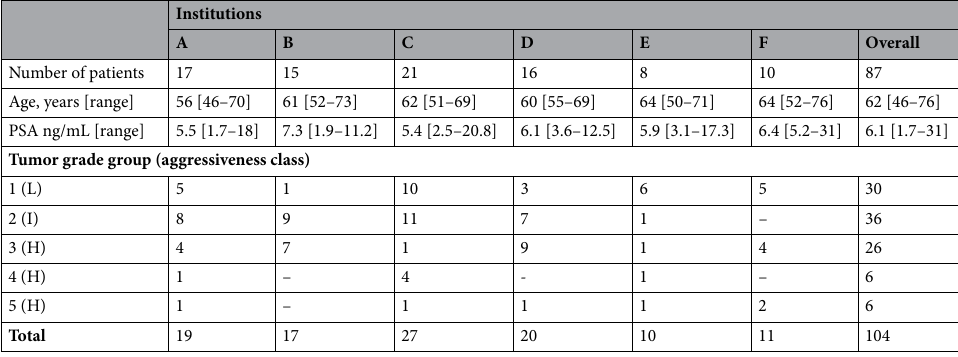
Table 1. Characteristics of patients and tumors. PSA prostate specific antigen, L low, I intermediate, H